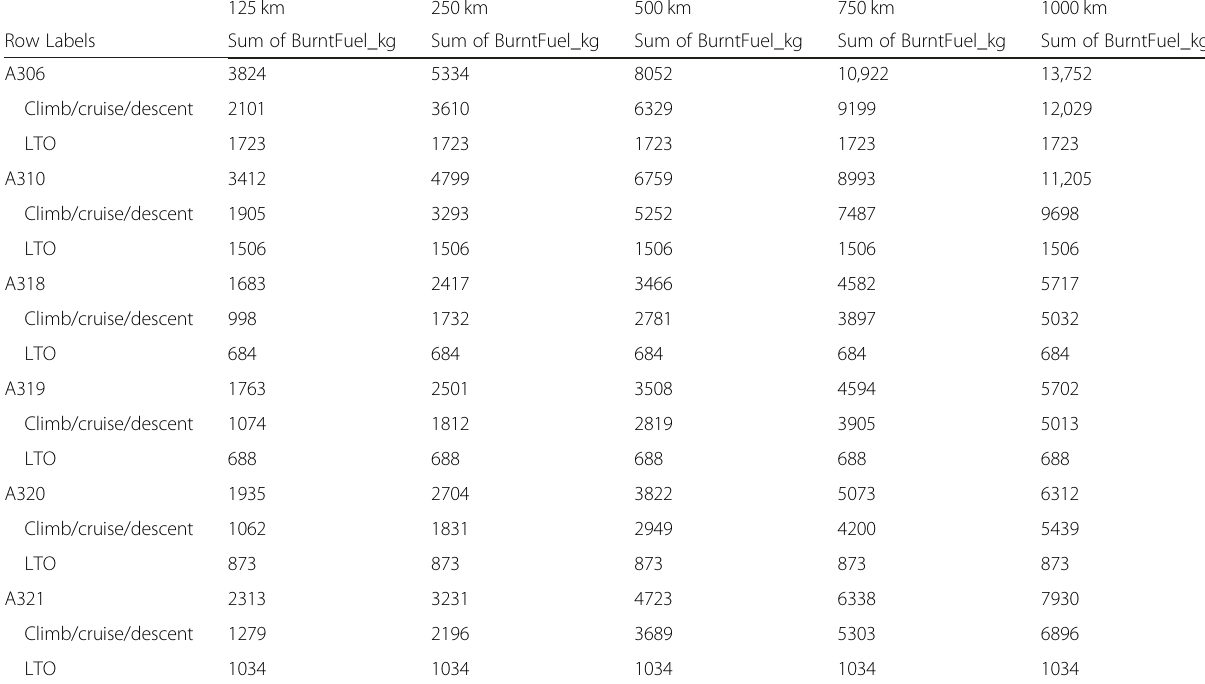
Table 2 Example of available emission data from EEA, showing emissions per kilometer during two different phases for various aircrafts